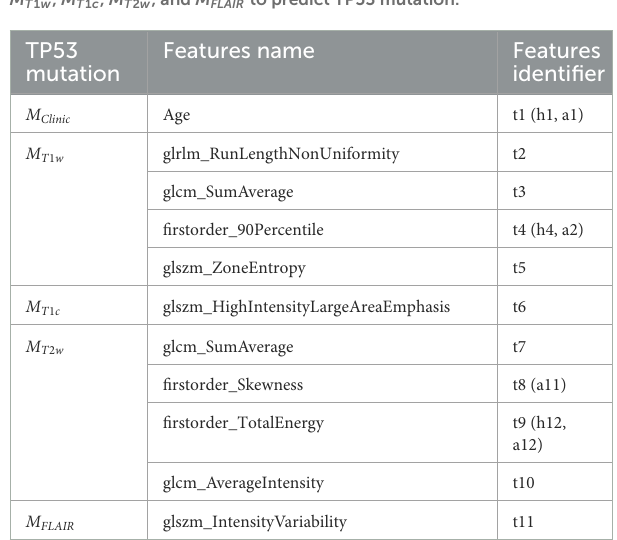
TABLE 5 Subsets of features selected by the five different models M Clinic , M T 1 w , M T 1 c , M T 2 w , and M FLAIR to predict TP53